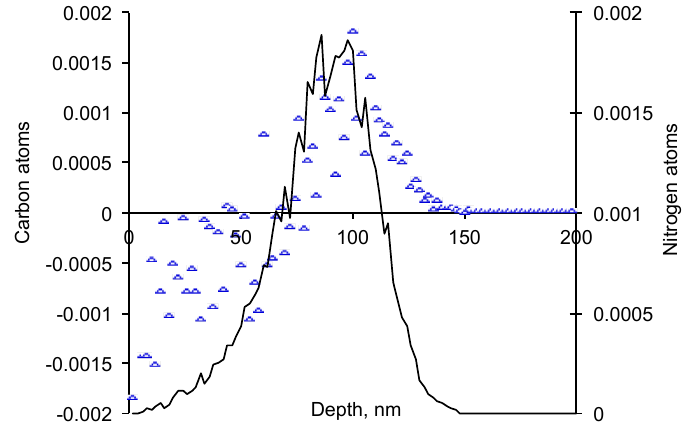
Figure 3. Stopped nitrogen ion profile (black line, units are stopped nitrogen atoms/nm 3 per penetrated nitrogen ion/nm 2 ) and carbon atoms balance (units are replaced carbon atoms/nm 3 per penetrated nitrogen ion/nm 2 ) with depth of EPDM rubber. By SRIM calculations.